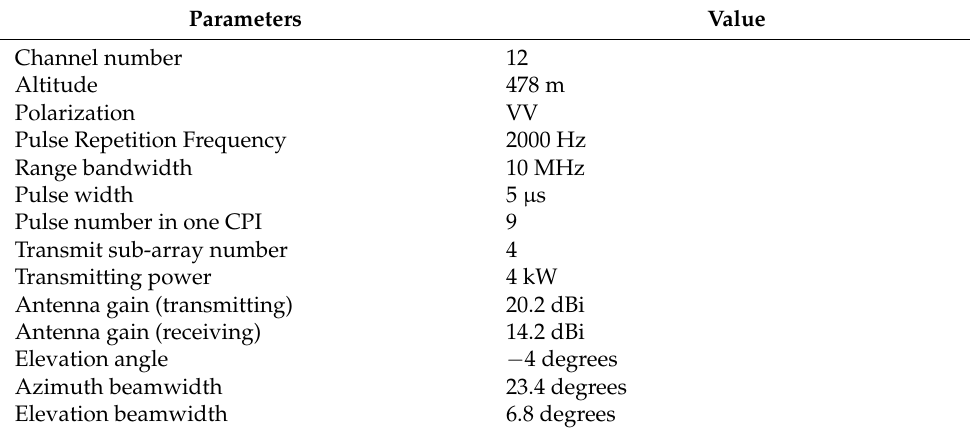
Table 3. The multichannel sea clutter measurement radar parameters.